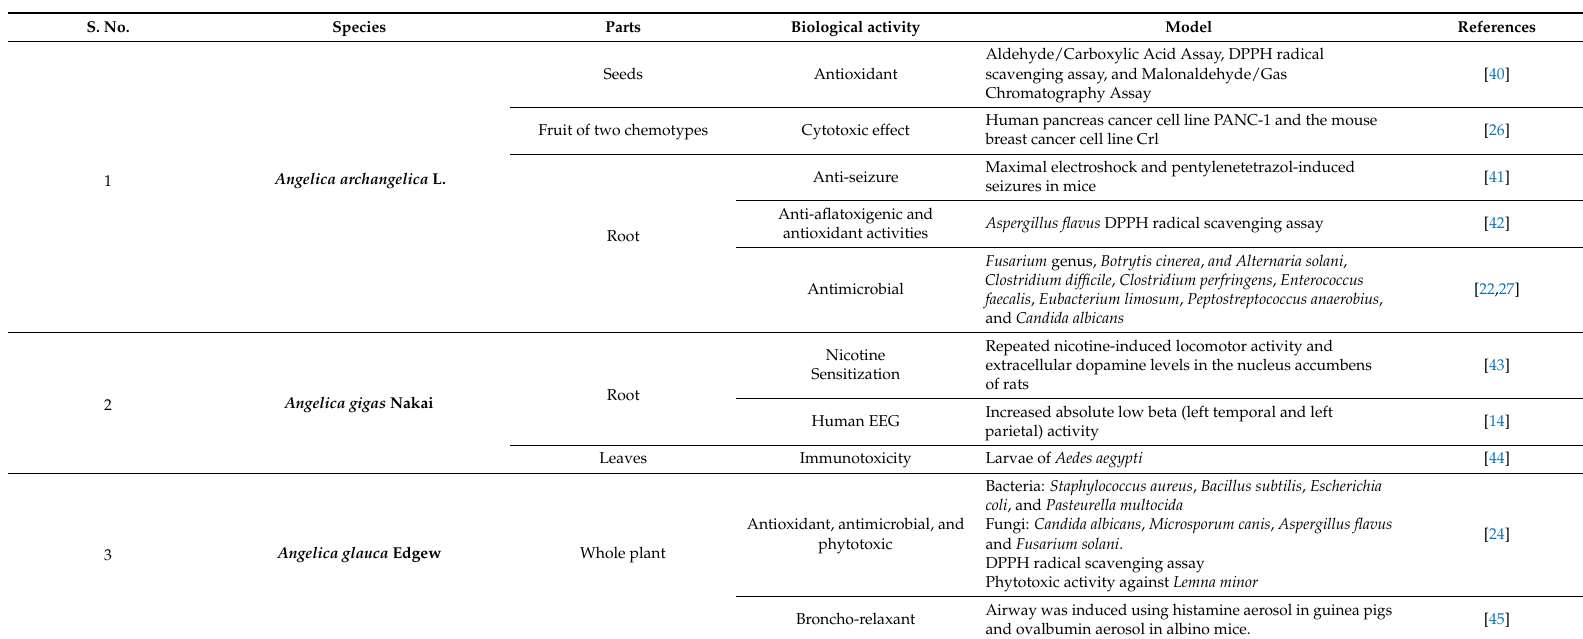
Table 2. Biological activities of essential oils from different Angelica